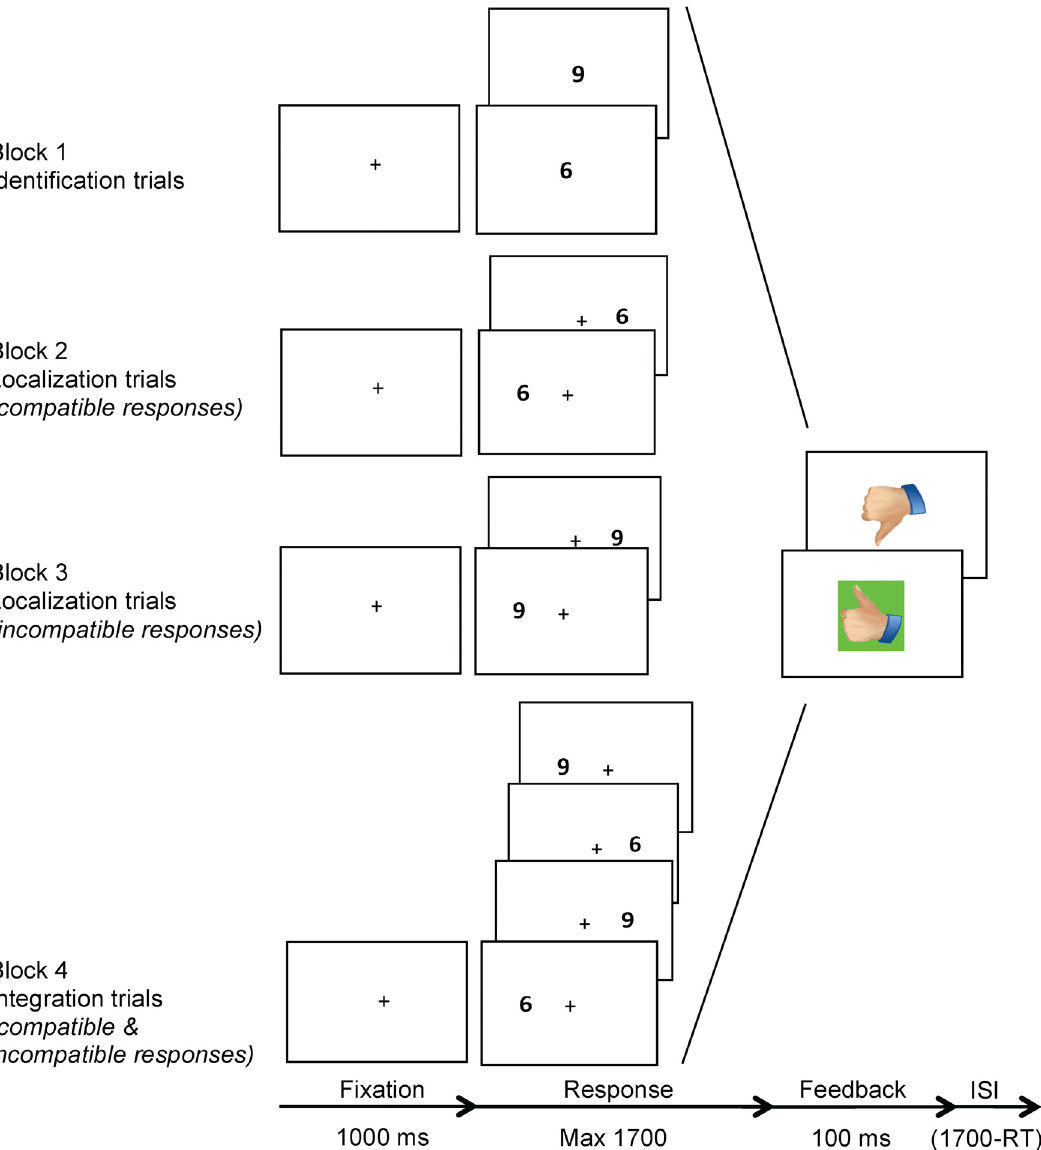
Fig 1. Visual Integration Test procedure. Note . The Visual Integration Test consisted of three conditions: the identification, localization and integration conditions, administered in four sequential blocks. The identification condition (block 1) required visual processing of identity: the target was digit ‘ 6 ’ or ‘ 9 ’ presented in the center of the screen and subjects were required to press the left or right button on a response box, respectively. The localization condition (block 2 and 3) required visual processing of the location of targets that were presented on the left or right side of the screen. In block 2, the target was ‘ 6 ’ and the required response was compatible with the target location. In block 3, the target was '9' and the required response was incompatible with the target location. The integration condition (block 4) required processing of the visual identity as well as location of targets presented on the left or right of the screen, measuring visual integration. The targets were either '6' or '9', and they required compatible and incompatible responses, respectively. In other words, a ‘ 6 ’ presented on the right side of the screen required a right button response, whereas a ‘ 9 ’ presented on the right side of the screen required a left button response, and vice versa. ISI = inter-stimulus